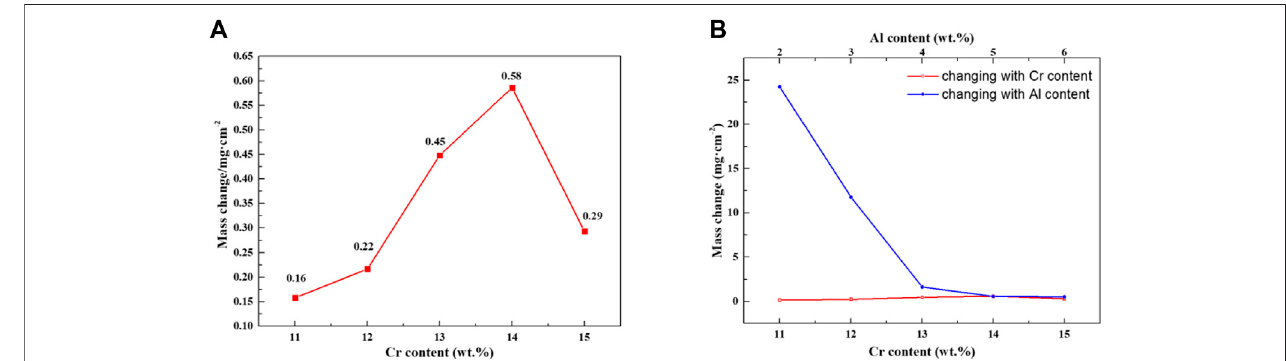
FIGURE 14 | Oxidation weight gain of Fe – x Cr – 6Al alloy with different Cr content after high temperature steam oxidation.